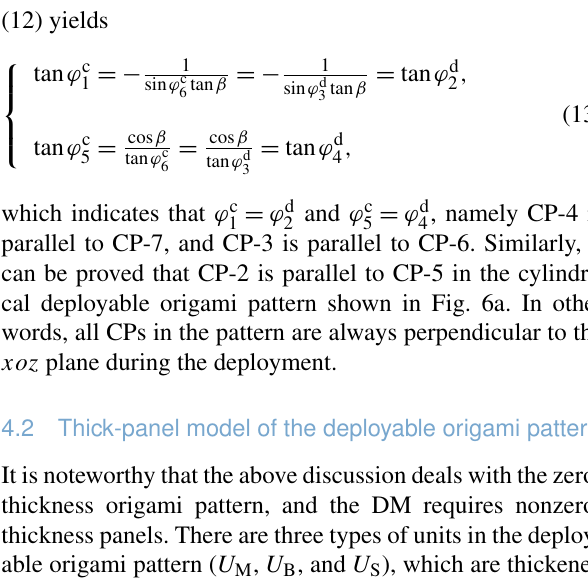
Figure 5. Kinematic analysis of the deployable string: (a) the relationship between ϕ a and ϕ b in U B -B; and (c) the relationship between ϕ c 7 ∈ [ 0 ,π separately. ϕ b , ϕ c 45 45